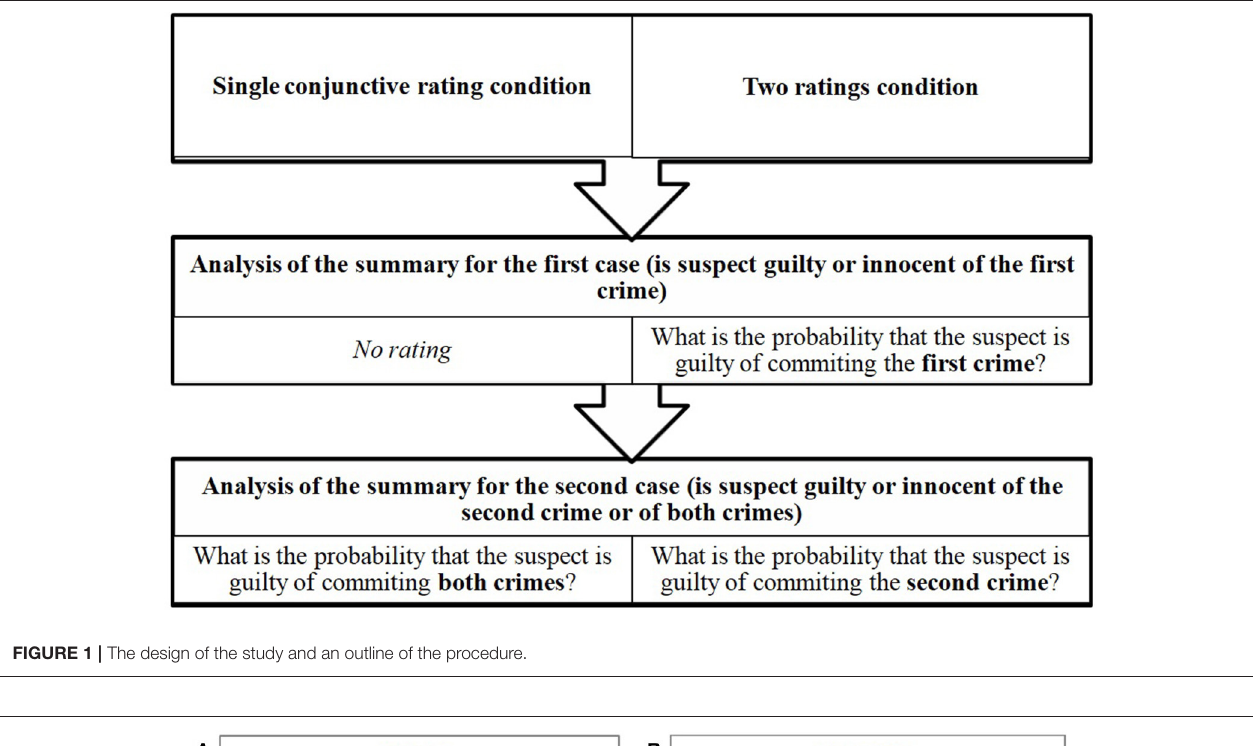
FIGURE 1 | The design of the study and an outline of the procedure.